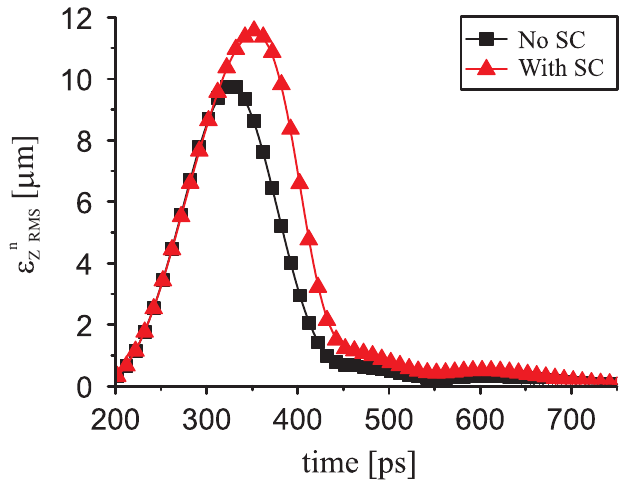
FIG. 15. (Color) Time evolution of the normalized RMS emit- tance in the longitudinal direction ( " N taking the effects of space charge into account.